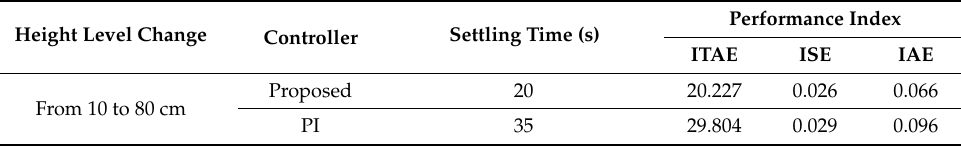
Figure 11. Responses of liquid level control: ( a ) liquid level and ( b ) influent feed. Table 3. The performance comparison of the controllers for liquid level